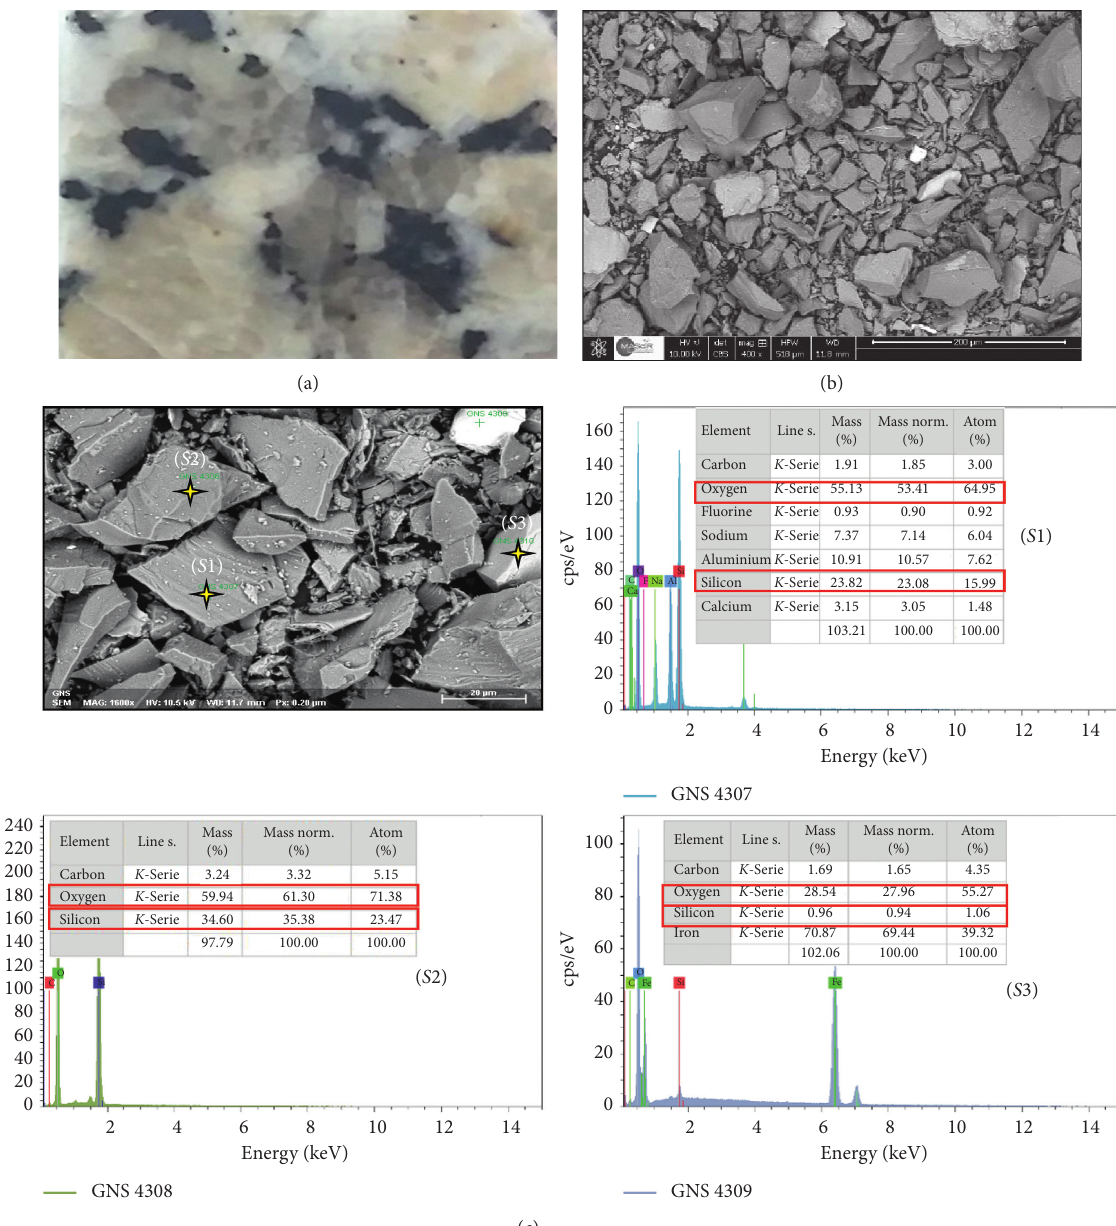
Figure 3: Optical image (a), SEM images (b) and (c), and corresponding local EDS analysis in different sides (S1, S2, and S3) of Gris Pinhel